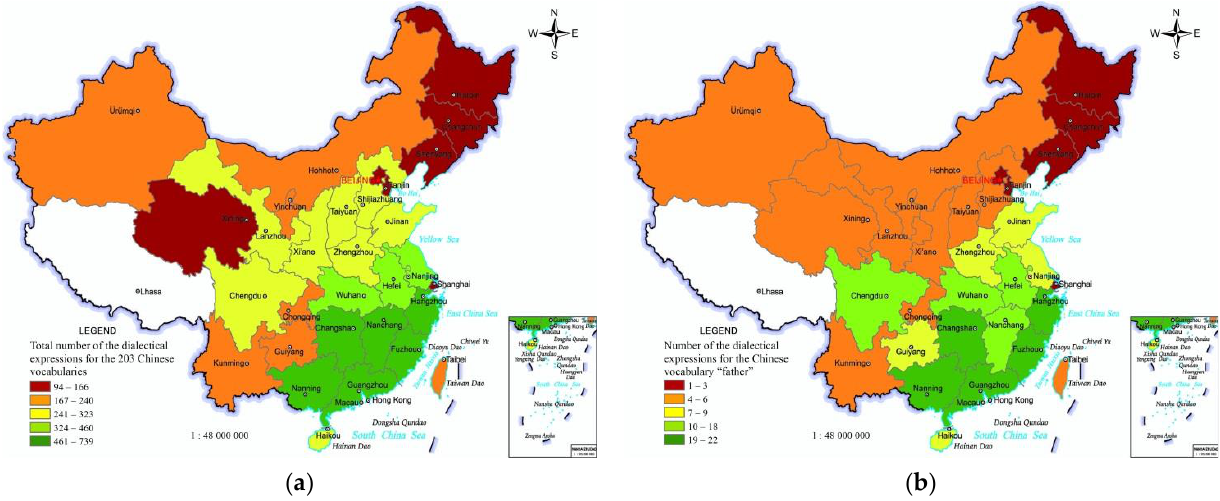
Figure 3. Distribution of lexical diversity of Chinese dialects in China. ( a ) Total number of the dialectical expressions for the 203 Chinese words. ( b ) Number of Chinese dialects expressions of the Chinese word “father”.